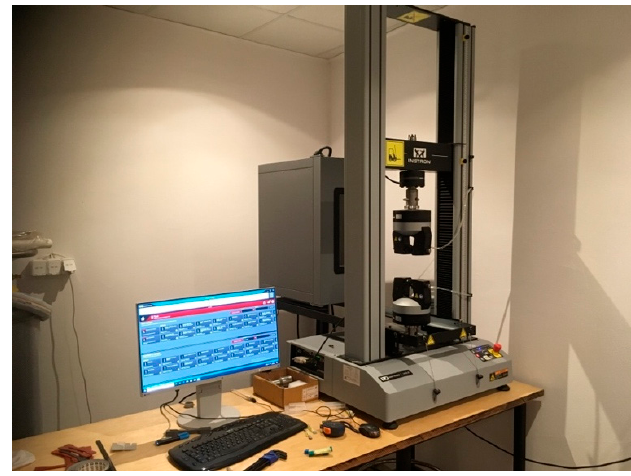
Figure 11 . Tensile testing machine Figure 11. Tensile testing machine.